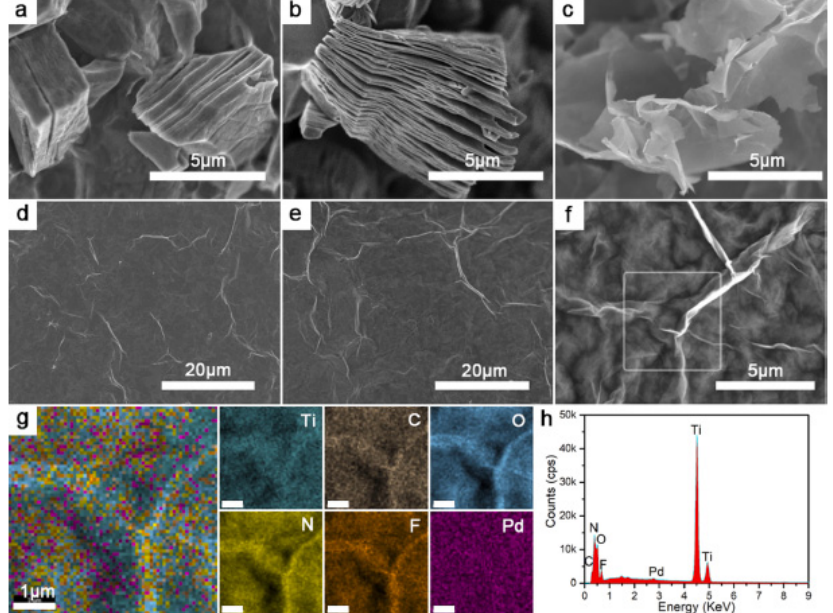
Figure 10. SEM and EDX images of the material surface morphology. ( a ) SEM image of bulk Ti 3 AlC 2 ; ( b ) morphology of the commercial Ti 3 C 2 T x ; ( c ) SEM image of d-Ti 3 C 2 T x after intercalation; ( d ) mor- phology of/d-Ti 3 C 2 T x film; ( e – h ) Pd (II)@alkyne-PVA/d-Ti 3 C 2 T x film surfaces morphology, element mapping (1 µm scale bar), and EDX spectrum [109].